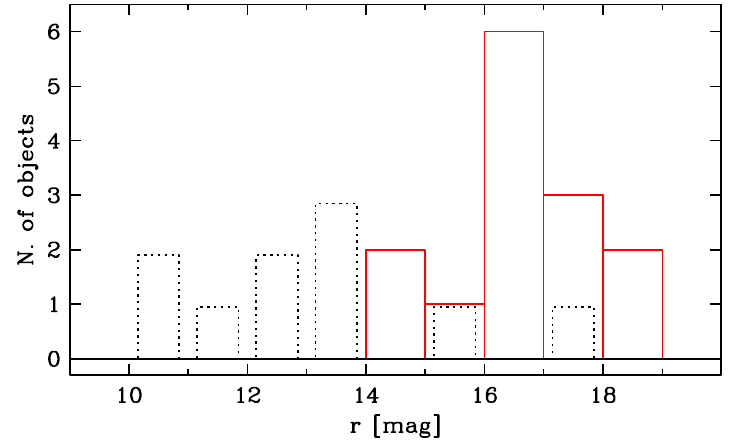
Fig. 2. Distribution of r magnitudes for the new IPHAS symbiotic stars (solid line histogram), compared to the systems previously known in the IPHAS survey area (dotted